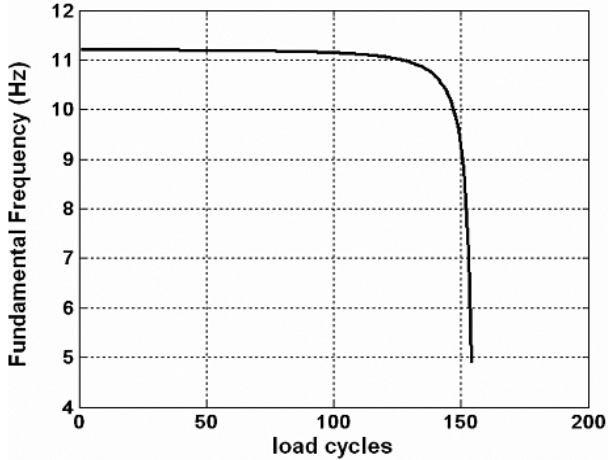
Fig. 7. Fundamental frequency decay with crack